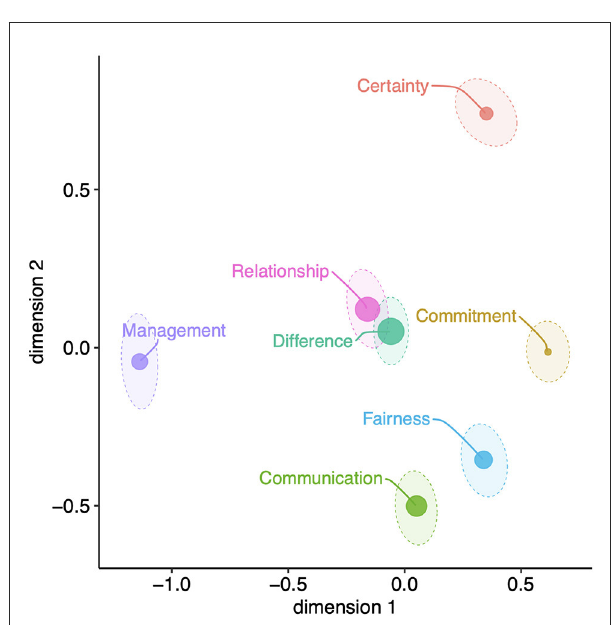
FIGURE4 Multidimensional scaling representation of the associations of the seven problems. The dashed ellipses show the 95% confidence intervals of the position of the seven problems. The dot size shows the contribution (stress per point, SPP) of the seven problems to the global stress of the